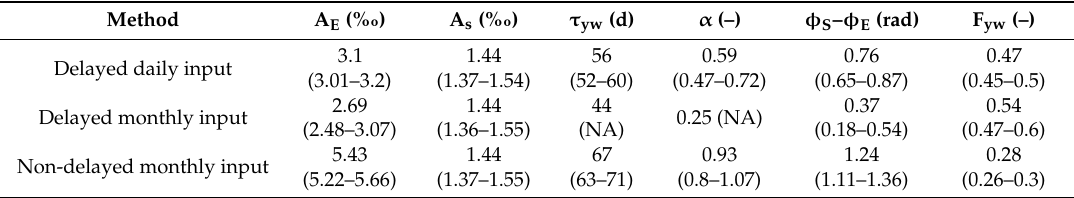
Table 1. Amplitude, threshold age, shape parameter and phase shift for the three applied F yw approaches (with delayed daily, delayed monthly and non-delayed monthly input). The interquartile range (in brackets) is estimated from 10,000 calculations.